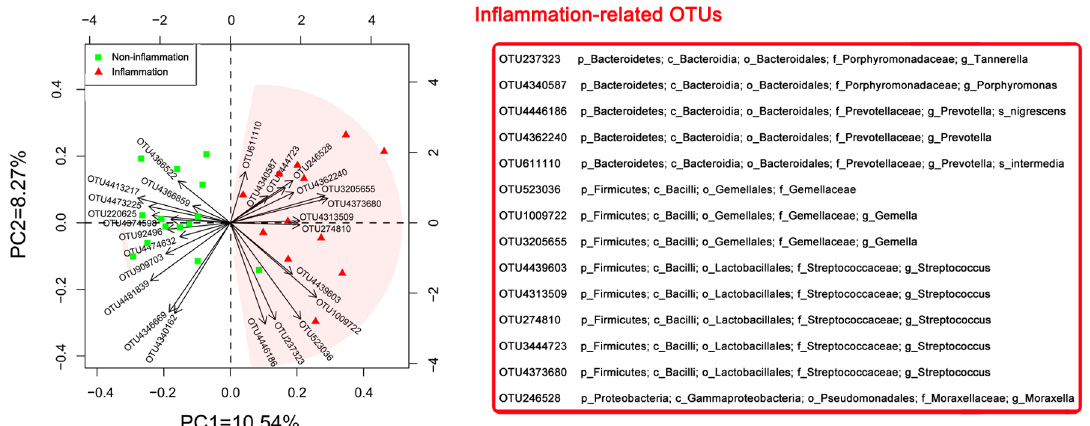
Fig 3. Principal component analysis (PCA) of the pre-operative OTUs information for the post-operative inflammation and non-inflammation groups. Based on 26 different OTUs of the pre-operation (relative abundance higher than 0.01%) between the two groups, the inflammation samples appeared to cluster together in the direction opposite to that of the non-inflammation samples. The 14 OTUs with the pink shadow on the right of the diagram were closely related to post- operative inflammation at the grafted